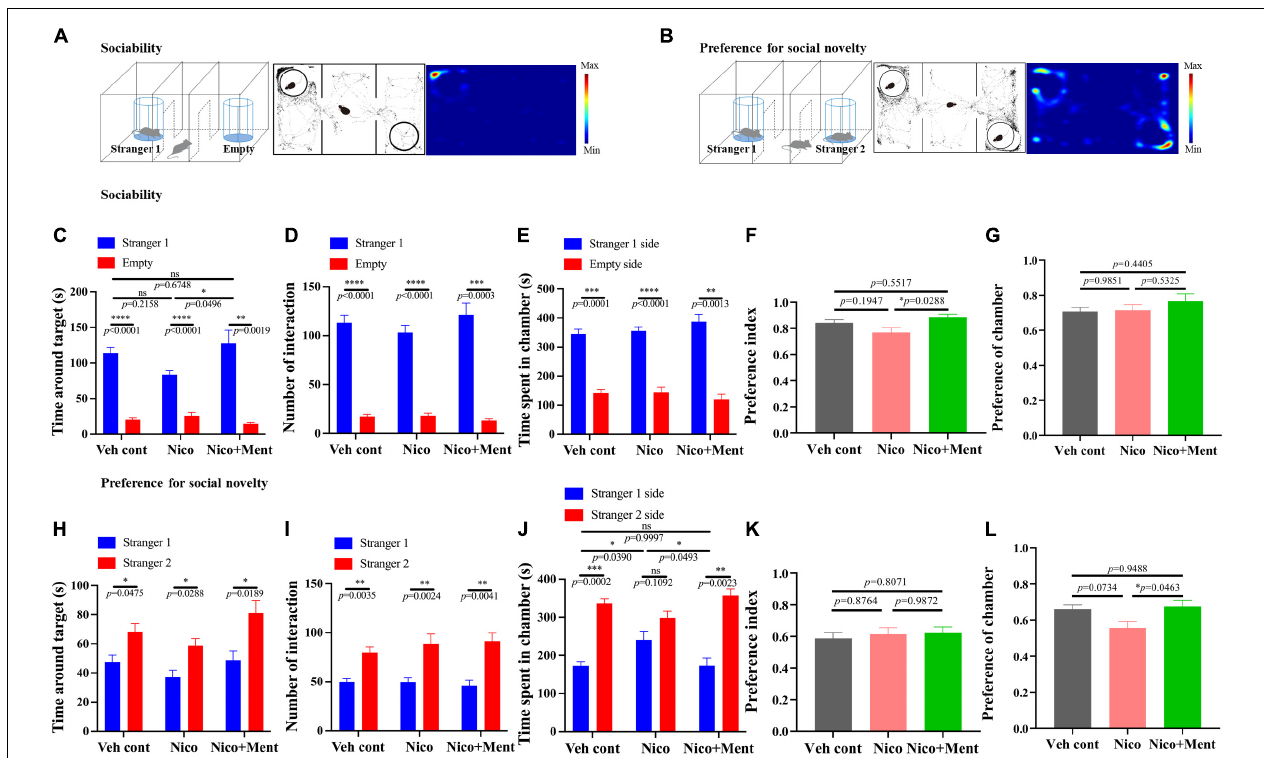
FIGURE 3 | Social behavioral assessments in mice after long-term vapor exposure. Schematic diagram of two parts of the Three-Chamber Test (TCT); stage one (A) and stage two (B) . (A,B) Left: the schematic diagram of the sociability session and the social novelty session of the TCT. Center: the trajectory graphs represent the movements of the tested mouse during the sociability session and the social novelty session, respectively. Right: the heatmaps represent the trajectory of motions in mice. (C–G) Social behavioral assessments of tested mice in the sociability session. Time around target mouse [ F ( 2 , 20 ) = 3.383, p = 0.0543] (C) and the number of interactions with stranger 1 [ F ( 2 , 20 ) = 0.9427, p = 0.4062] or empty cage (D) . Time spent in the chambers of stranger 1 side or the empty side (E) . (F) Preference index of stranger 1 among groups. F ( 2 , 20 ) = 4.040, p = 0.0336. (G) Preference of stranger 1 chamber against the empty side among the exposure